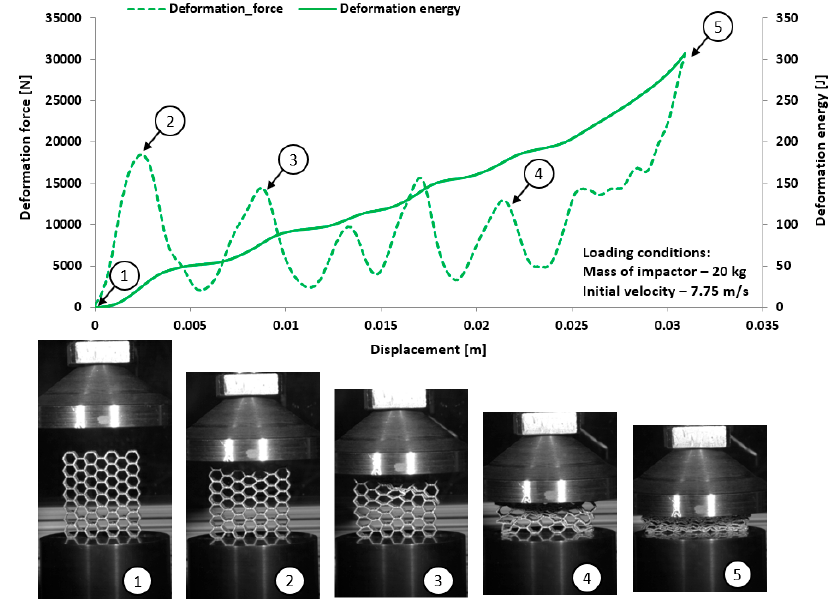
Figure 19. The results of dynamic tests obtained for honeycomb specimen No. 3 (1–5 stages of deformation during dynamic compression test).